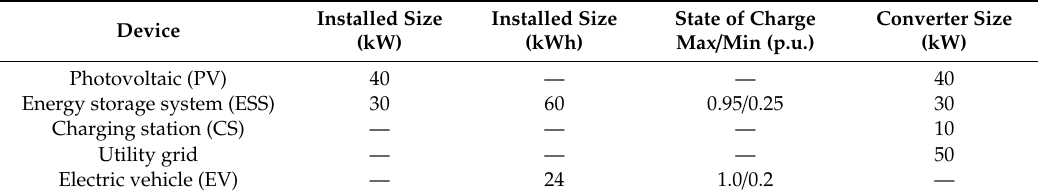
Table 1. Test system. Sizes of installed